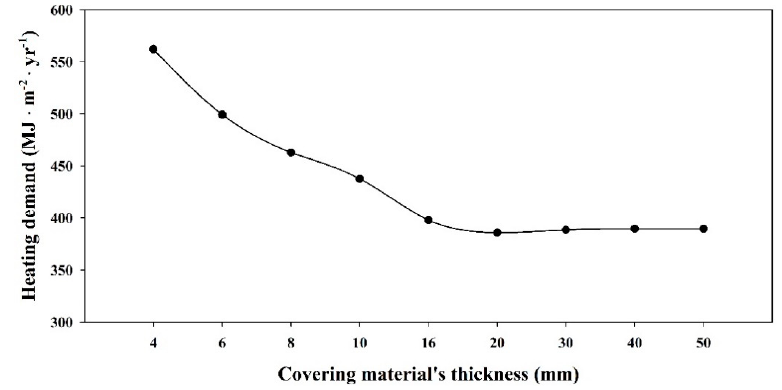
Figure 17. Effect of the thickness of PMMA covering material on the annual heating demand of the greenhouse modeled with gothic ‐ shaped greenhouse.